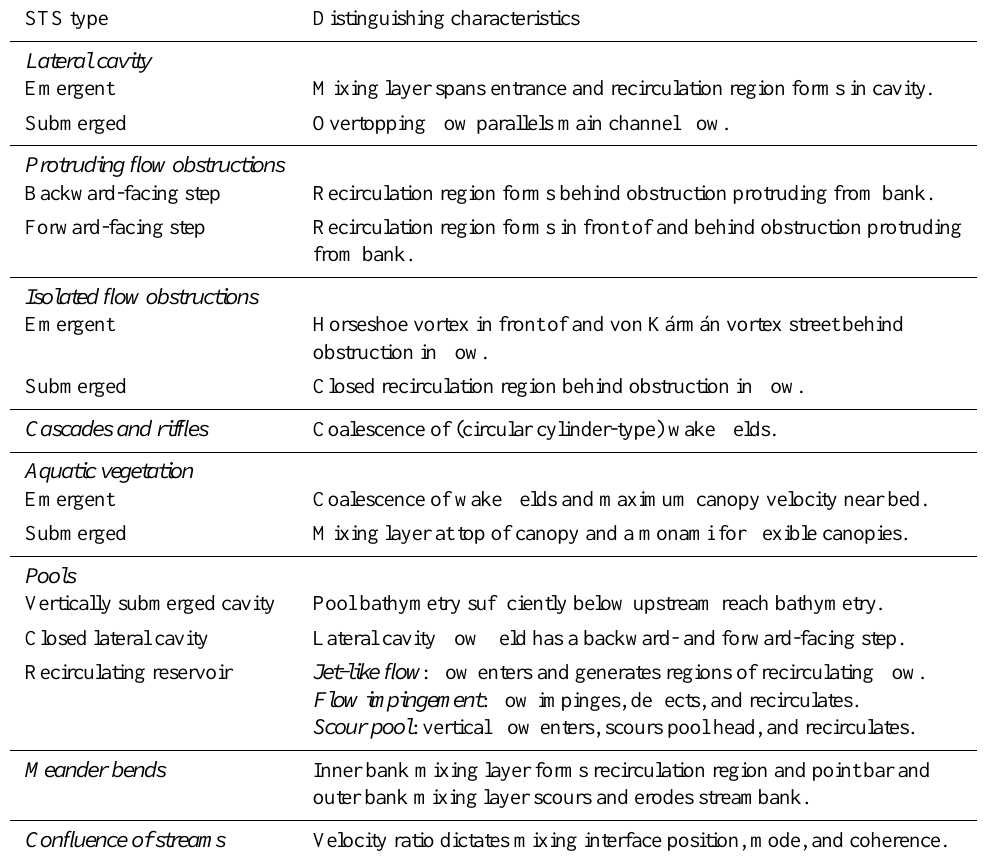
Table 1. Summary of STS classification